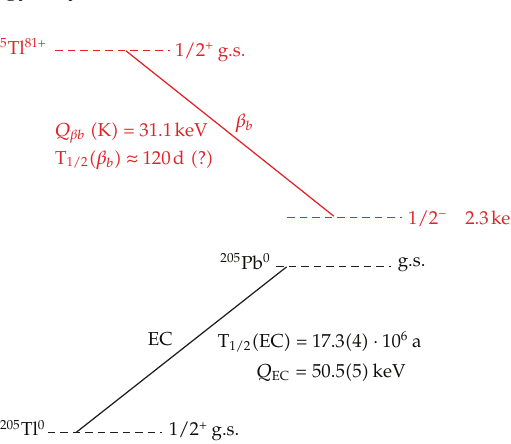
Figure 3: The neutral 205 Tl 0 atom is stable with respect to β − decay into the continuum since the Q value for this decay is negative, Q β − (cid:8) − Q EC (cid:8) − 50 . 5keV. However, for bare (cid:2) 205 Tl 81 (cid:4) (cid:3) or hydrogen-like 205 Tl ions bound-state β decay becomes allowed, where the created electron remains bound in the K-shell of the daughter ion 205 Pb 81 (cid:4) . Due to the “saved” K-shell binding energy, the Q value for this decay (cid:2) Q β b (cid:2) K (cid:3)(cid:3) gets positive. Both, the capture of solar pp-neutrinos and the bound-state beta decay populate predominantly the first exited state (cid:2) 1 / 2 − (cid:3) of the 205 Pb nucleus at 2.3keV and share the same nuclear matrix element for this transition. Therefore, the measurement of the bound-state β − decay probability of bare or hydrogen-like 205 Tl ions provides the unknown capture probability of the solar pp-neutrinos by the 205 Tl atoms. Based on the log ft values of comparable β − decays, the bound-beta half-life T 1 / 2 (cid:2) β b (cid:3) of bare 205 Tl ions was estimated by Takahashi and Yokoi (cid:6) 19 (cid:7) to about 120d. Since this extrapolated value has to be regarded as uncertain within (cid:2) at least (cid:3) a factor of three, only the measurement of the bound-beta half-life can provide a safe number with a reliable error margin for the capture probability of solar pp-neutrinos by 205